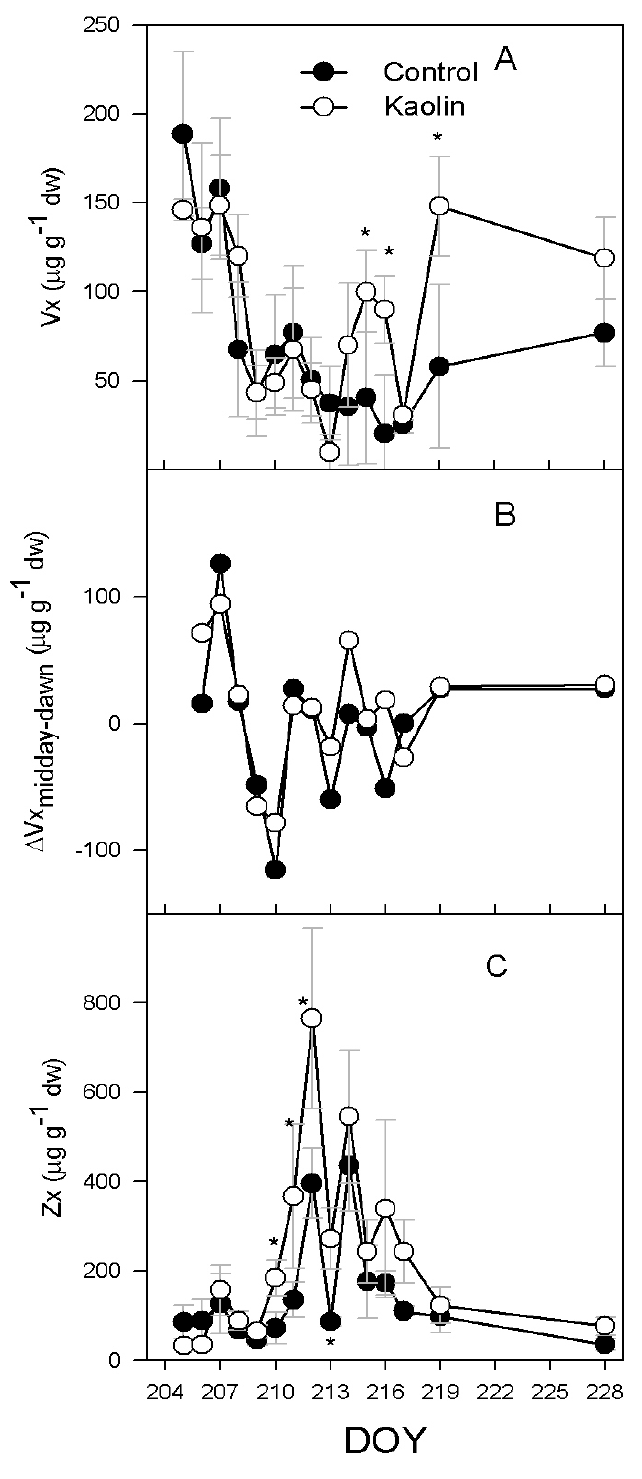
Figure 4. ( A ) Course of leaf violaxanthin (Vx) content at dawn; ( B ) midday to dawn Vx differences and ( C ) zeaxanthin (Zx) content at midday over the experiment, according to a progressive water shortage (DOY 209–217) and subsequent re-watering (at DOY 218), in vines subjected to the kaolin treatment and in controls. Bars represents standard error, n = 3. Asterisks indicate dates within which differences among treatment were significant ( p < 0.05). DOY: day of the year.